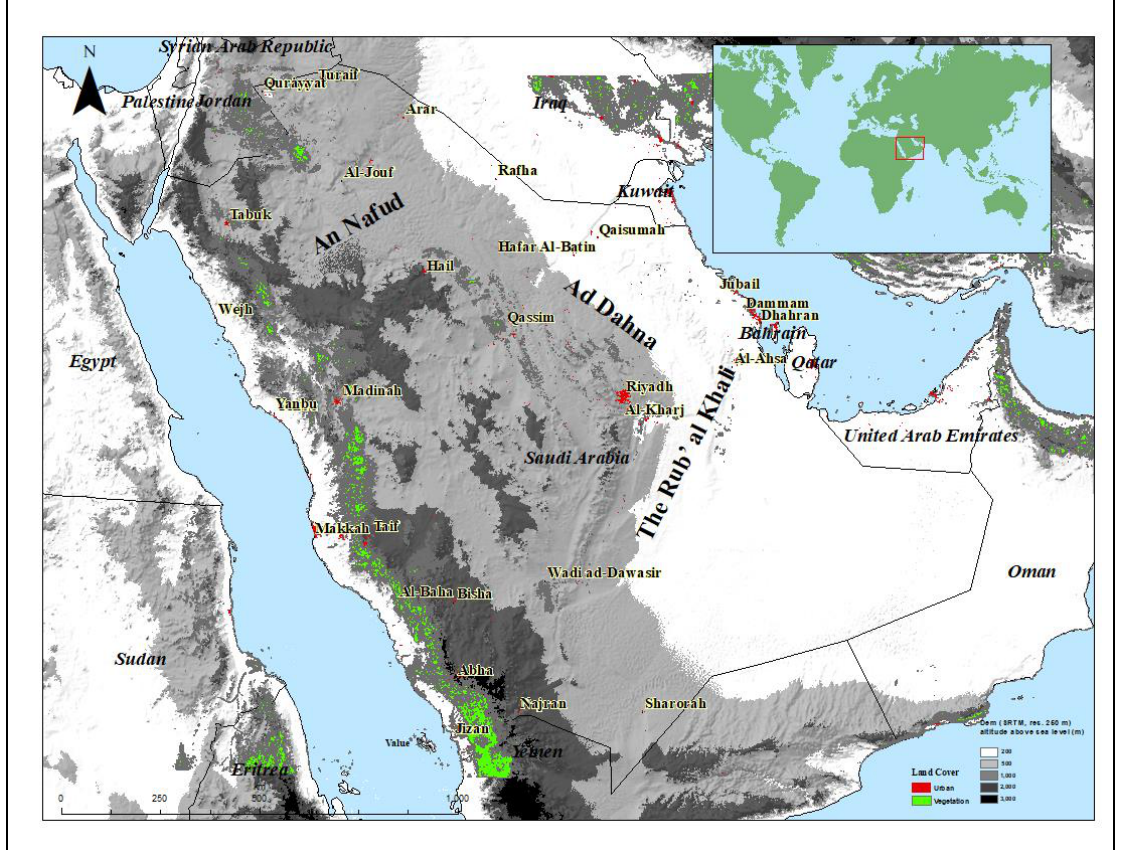
Figure 1. Overview map of the Arabian Peninsula with annotation of the major deserts, cities and vegetated areas with a topographic map (grey scaled) as background.